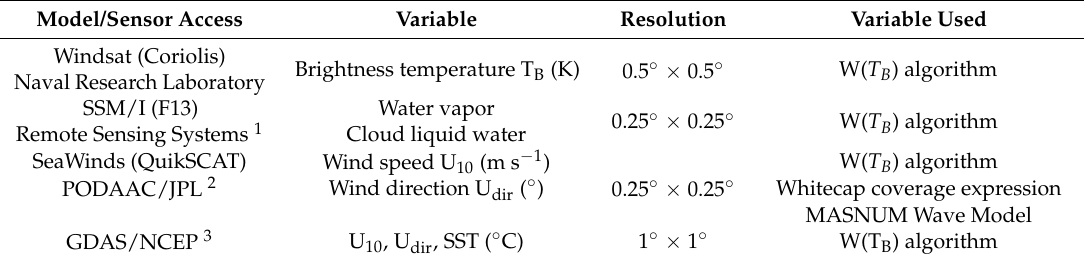
Table 2. Data source, grid resolution, variables used, and data